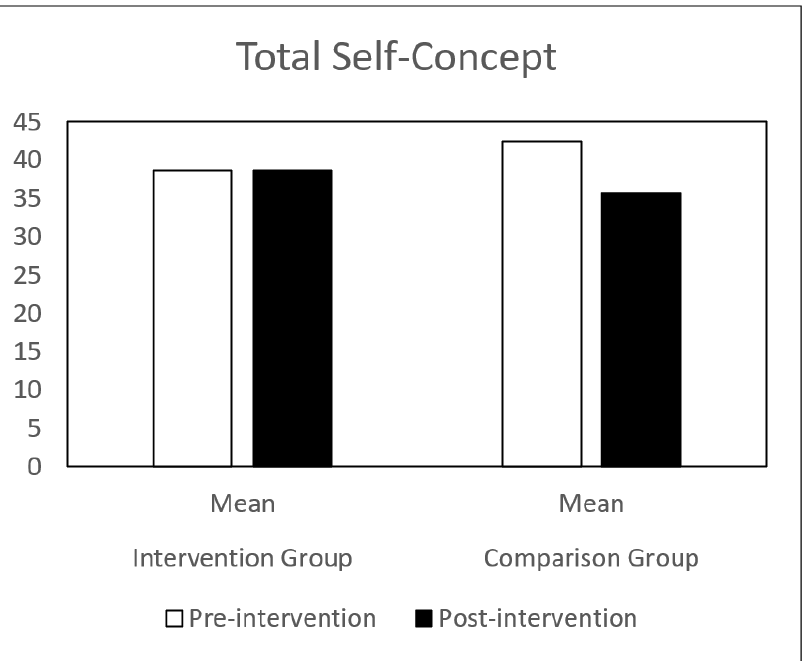
Figure 6. Happiness and Satisfaction mean in IG and CG at pre- and post-intervention.